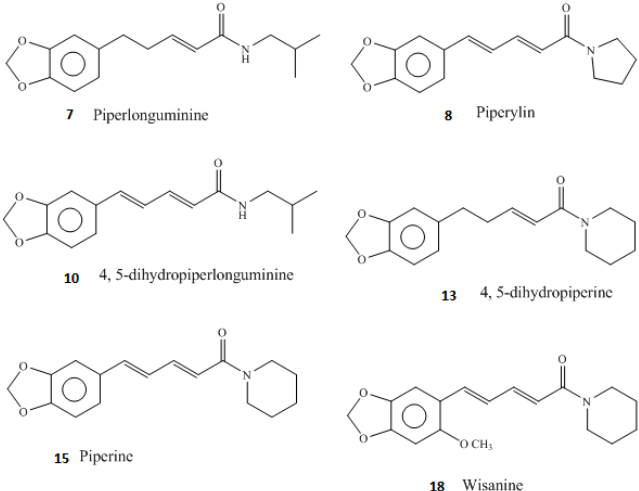
Figure 2. Chemical structures of some of the piperamide compounds found in this investigation from the hexane leaf extract of Piper guineense . The compounds are numbered from Table 4.